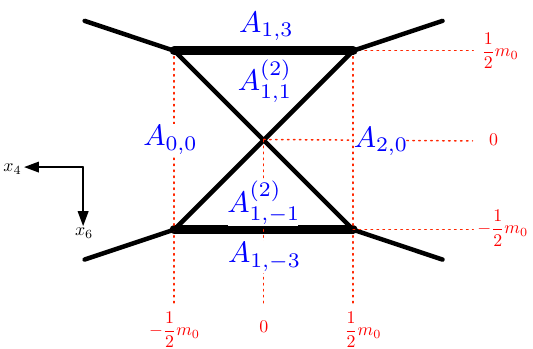
Figure 7. The blue letter A ( m ) indicates the largest A ( m ) in the region. The black solid lines are k;l k;l the boundaries of those regions and give the 5-brane web in the decompacti(cid:12)cation limit of the E 1 curve in Region 4